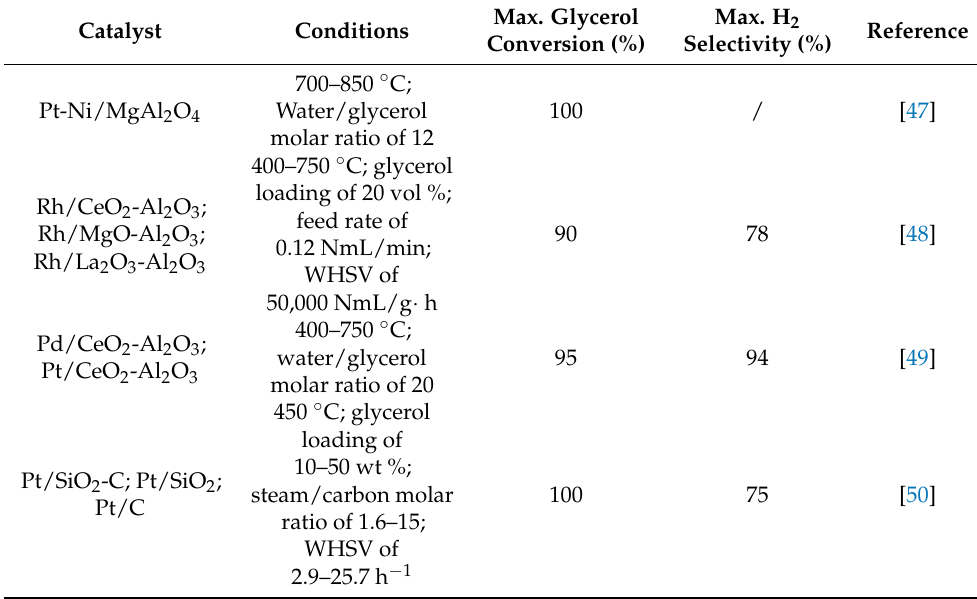
Table 3. Recent investigations on glycerol conversion for producing H 2 via steam reforming over noble-based